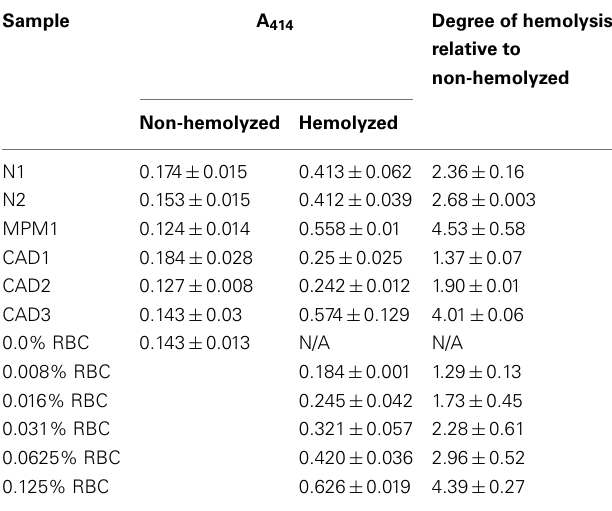
Table 2 | Free hemoglobin measurements for matching sample pairs and dilution